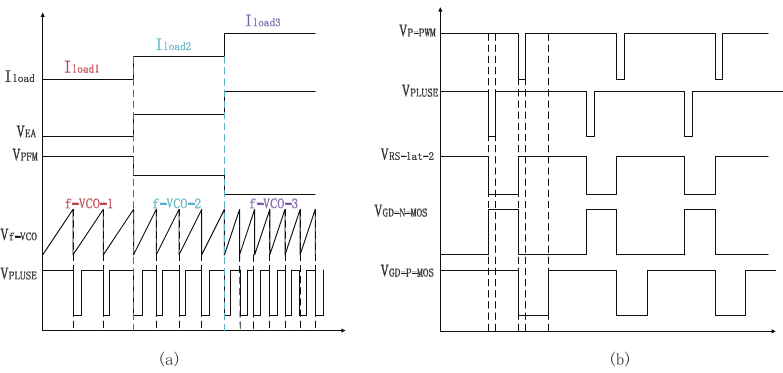
Figure 4. Main signal timing relationship in PFM mode. ( a ) Correspondence between Iload, V EA , V PFM , V f − VCO , and V PLUSE in PCMC-PFM mode. ( b ) The logical relationships between V P − PWM , V PLUSE , V RS − lat − 2 , V GD − N − MOS , and V GD − P − MOS